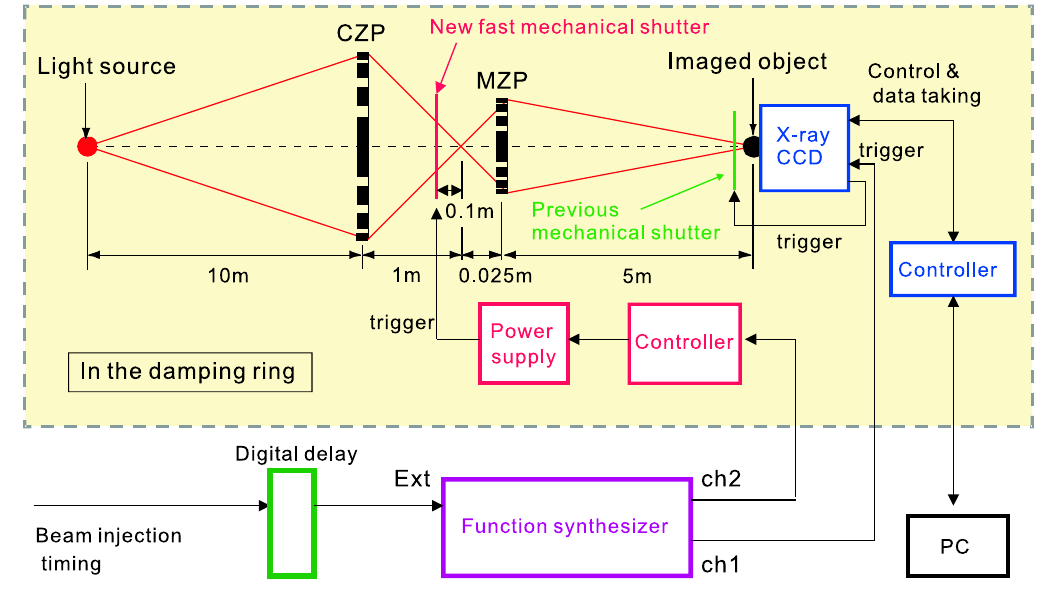
FIG. 6. (Color) Block diagram of the FZP monitor with a new fast mechanical shutter.